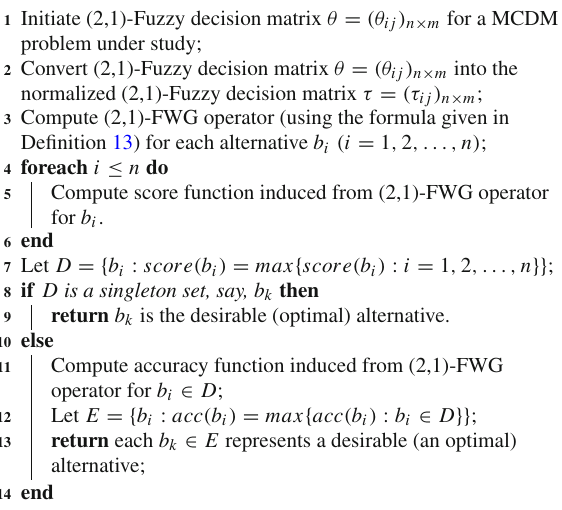
Algorithm 2: The algorithm of selection the optimal alternative(s) with respect to (2,1)-FWG operator